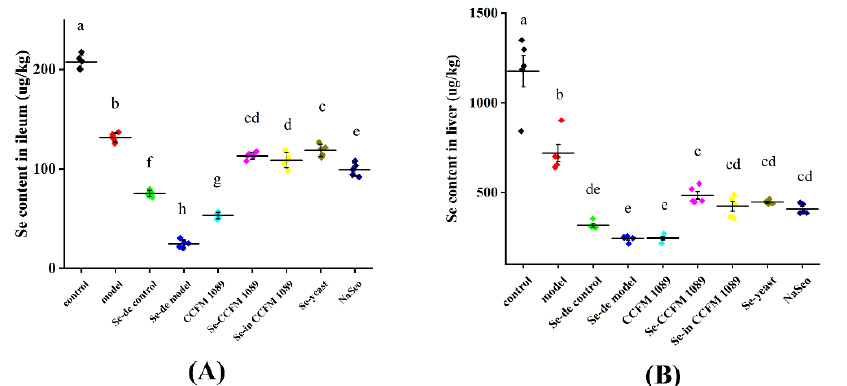
Figure 5. Se concentration in liver and ileum of mice. ( A ) Se content in ileum; ( B ) Se content in liver. Graphs show mean ± SD; n = 5. Significant differences are indicated by different superscript letters ( p < 0.05), and the same superscript letters above the bars indicate that the differences between the values are not statistically significant ( p > 0.05).